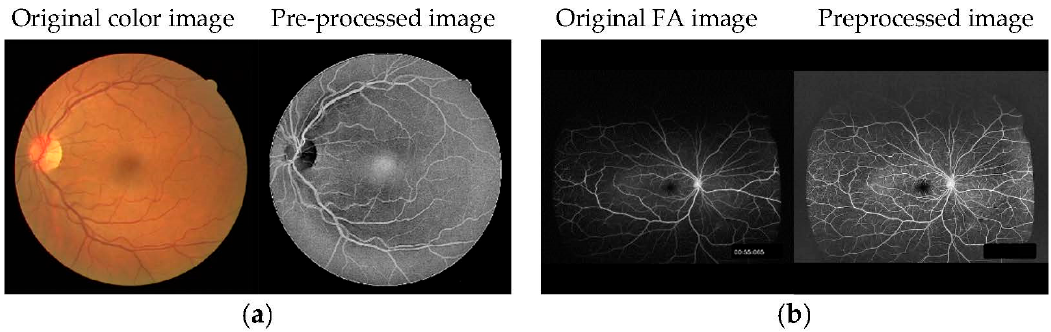
Figure 1. Examples of ( a ) training and ( b ) test images for U-Net. The RGB color image was pre- processed to resemble an FA image.